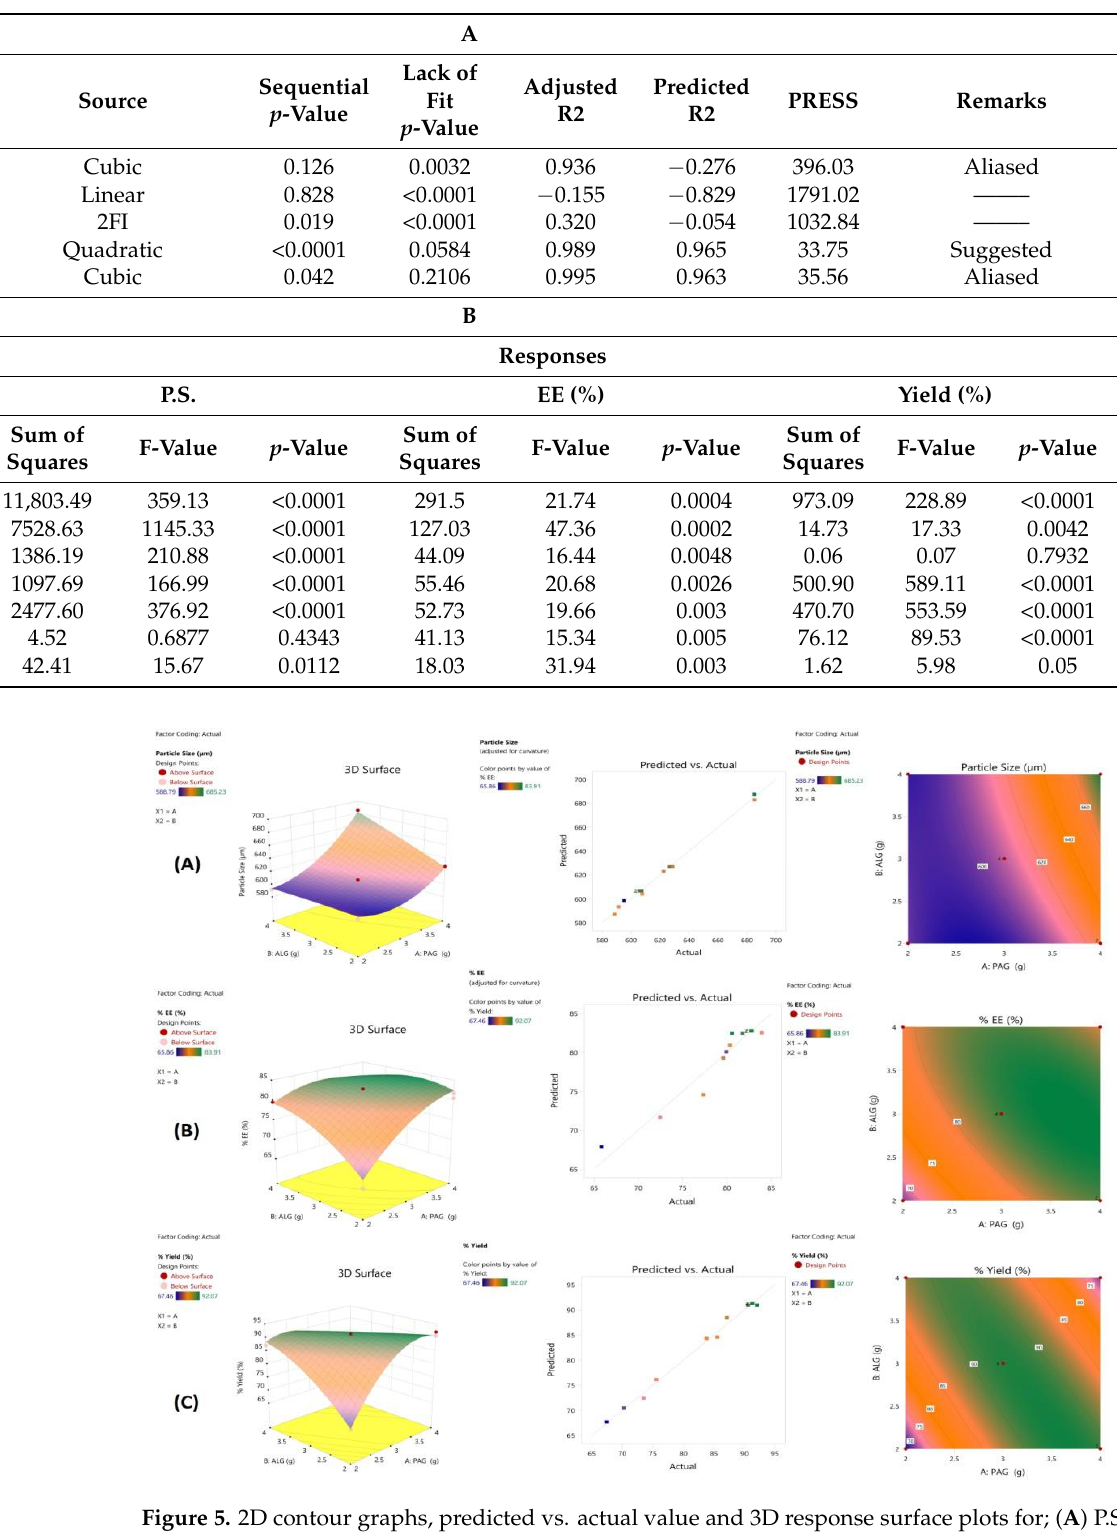
Figure 5. 2D contour graphs, predicted vs. actual value and 3D response surface plots for; ( A ) P.S. (particle size); ( B ) EE % (Encapsulation efficiency); ( C ) Yield